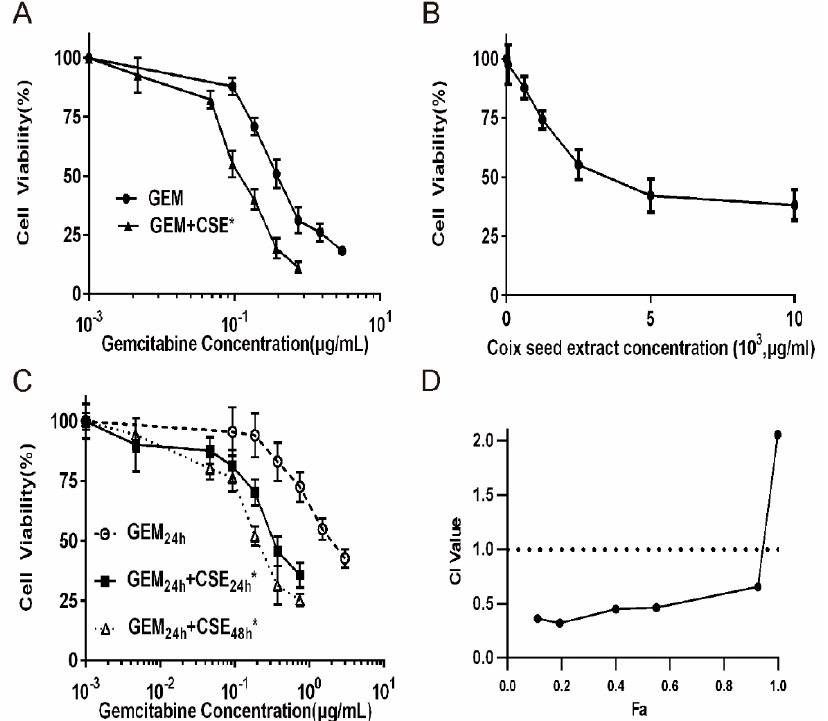
Figure 1. The combination of coix seed extract and gemcitabine exhibits synergistic cytotoxicity potency in pancreatic cancer cell line BxPC3 luc . ( A ) Cell viability of BxPC3 luc cells exposed to gemcitabine (GEM) alone for 48 hours (IC 50 values of gemcitabine = 0.54 ± 0.032 µ g / mL) or coix seed extract (CSE) alone for 72 hours, or co-treatment of coix seed extract and gemcitabine (GEM + CSE) for 72 hours (IC 50 values of gemcitabine = 0.13 ± 0.011 µ g / mL, p < 0.05). n = 6, mean ± SD, * p < 0.05 vs. GEM Group. ( B ) Cell viability of BxPC3 luc cells exposed to coix seed extract (CSE) alone for 72 hours. n = 6, mean ± SD. ( C ) Cell viability of BxPC3 luc cells exposed to gemcitabine (GEM) alone for 24 hours (IC 50 values of gemcitabine = 1.72 ± 0.024 µ g / mL), co-treatment with coix seed extract for 24 hours (GEM 24h + CSE = 0.30 ± 0.012 µ g / mL, p < 0.05) or 48 hours (GEM + CSE 24h , IC 50 values of gemcitabine 48h 48h , IC 50 values of gemcitabine = 0.20 ± 0.014 µ g / mL, p < 0.05). n = 6, mean ± SD. * p < 0.05 vs. GEM Group. ( D ) The combination index (CI) of the anti-proliferation e ff ects of gemcitabine (GEM) and coix seeds extract (CSE) in BxPC3 luc cells. Fa refers to cell viability inhibition rate. CI > 1 represents antagonistic cytotoxicity; CI = 1 represents addictive cytotoxicity; CI < 1 represents synergistic